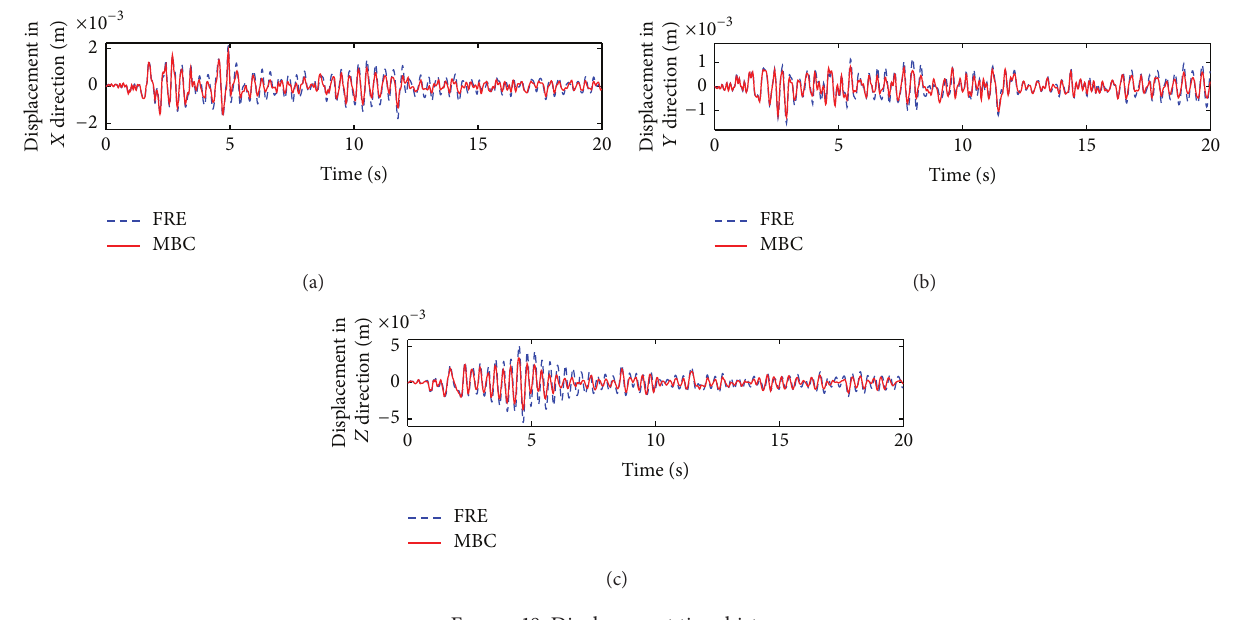
Figure 18: Displacement time history. Table 5: Maximum acceleration response and reduction of typical